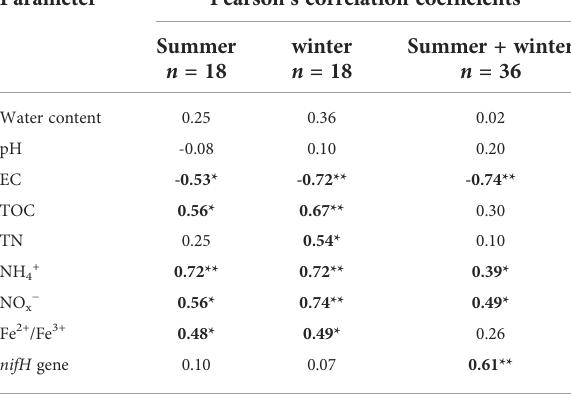
Bold values indicate signi fi cant correlation coef fi cients. Signi fi cance levels: *p < 0.05, **p <